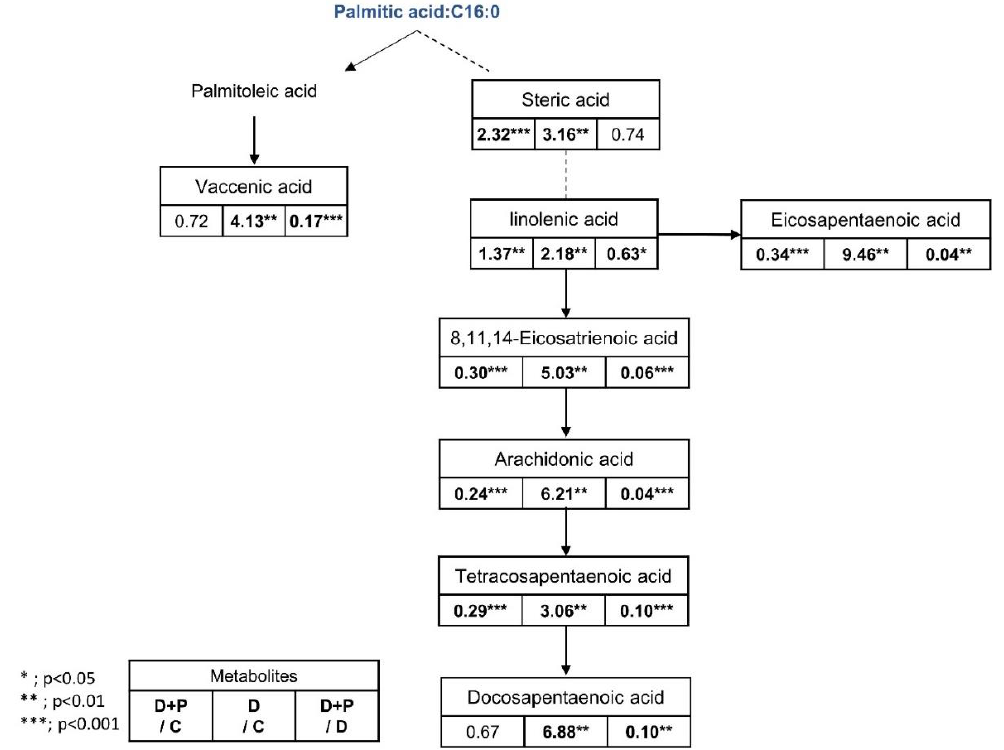
Figure 10. Fatty acid pathway and fold change table. Table showing the fold change in fatty acids in the D + P-, D, and D + P-treated groups from metabolomics data (n = 5 per condition), *** p < 0.001, ** p < 0.01, * p < 0.05, Student’s t -test.